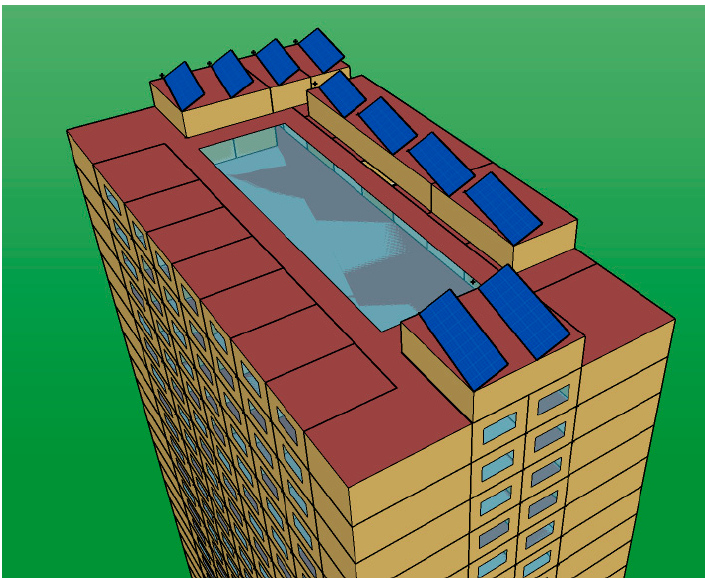
Figure 13. General overview of solar panels.